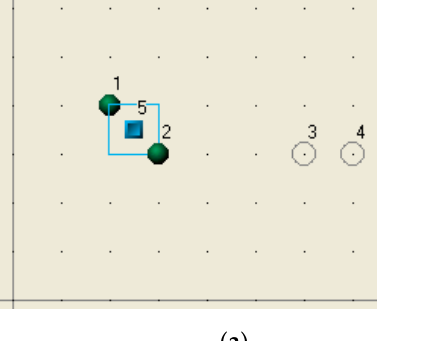
Figure 2. ( a ) Formation of Cluster 5; ( b ) Formation of Cluster 6